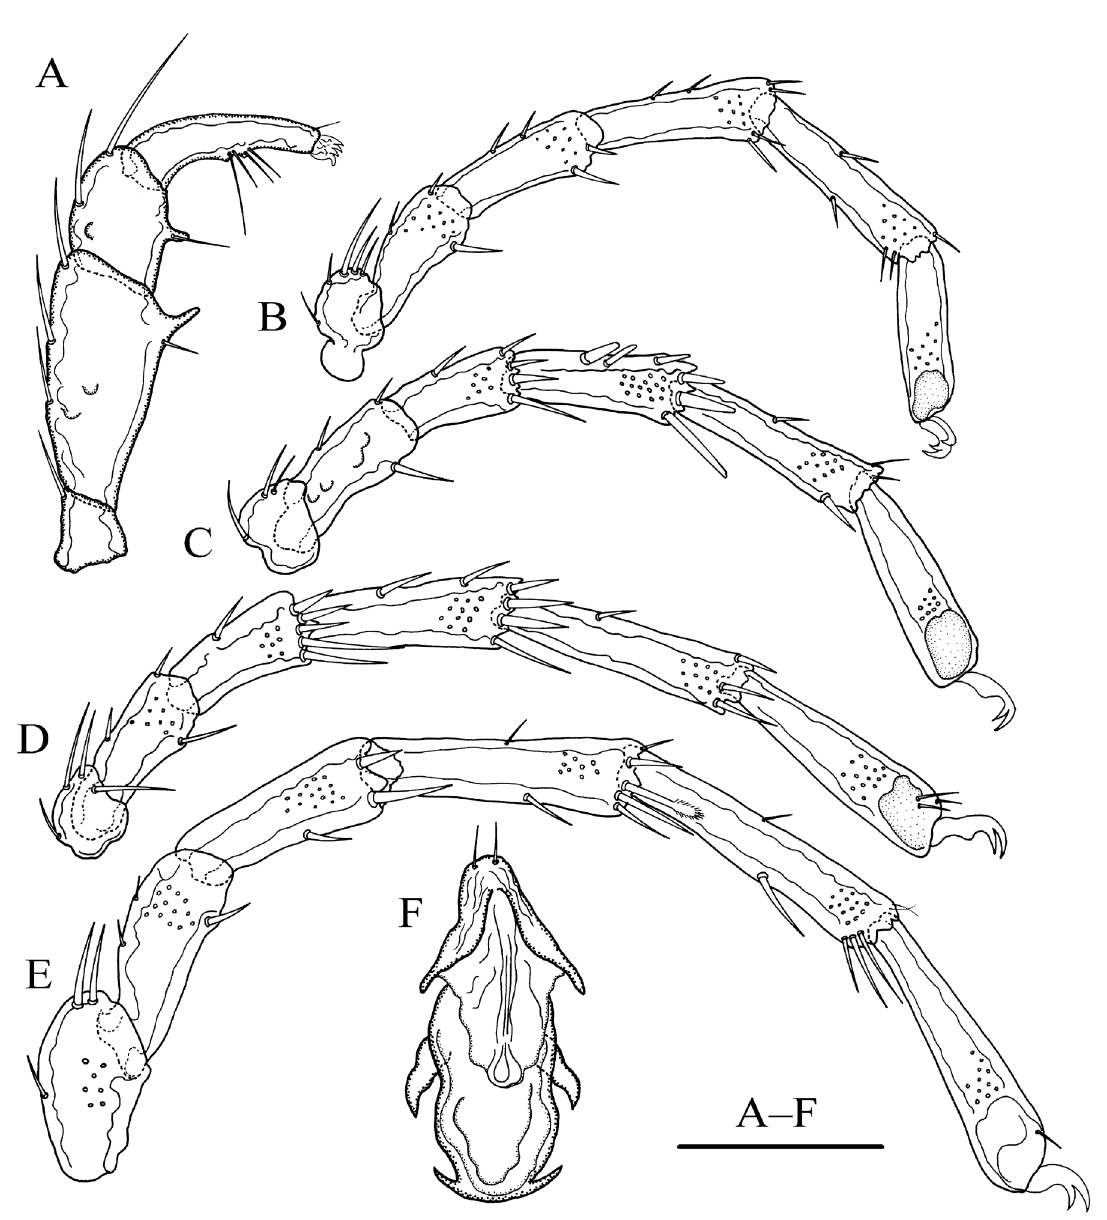
Fig. 2. Torrenticola suptilisrostrum Gu & Guo sp. nov., ♂ , holotype (FJ-TO-20180801). A . Palp, lateral view. B . leg-I. C . leg-II. D . leg-III. E . leg-IV. F . Ejaculatory complex. Scale bar = 100